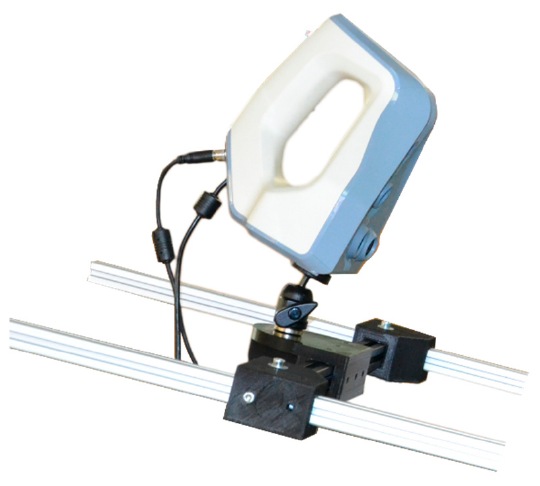
Figure 6. Spider Artec 3D scanner. (Source: Self-made).